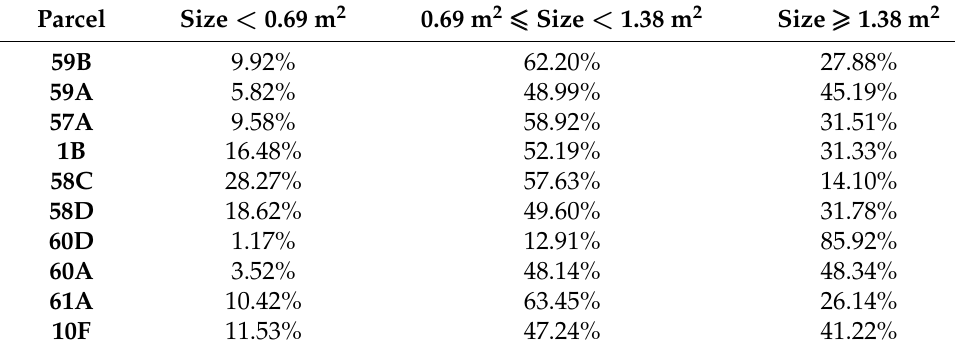
Table 4. Percentage of vines according to their size.